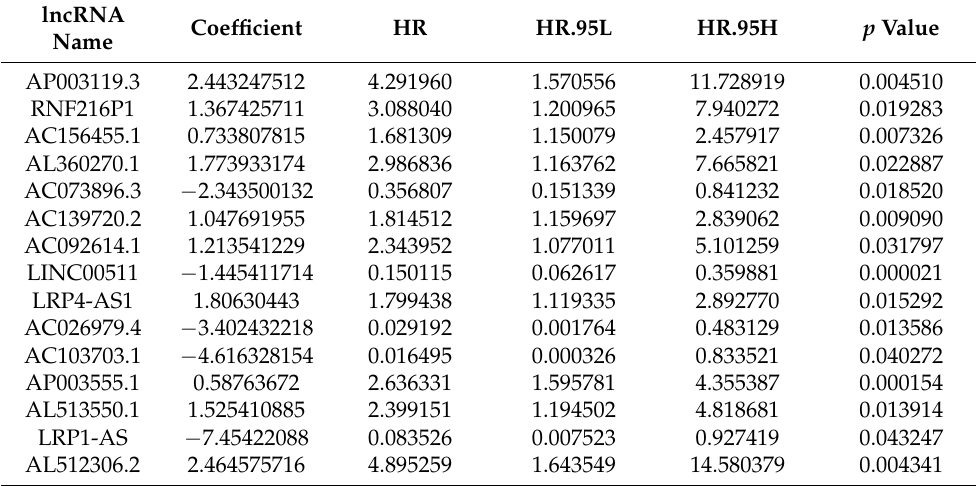
Table 1. 15 prognosis-related lncRNAs obtained based on multivariate Cox regression